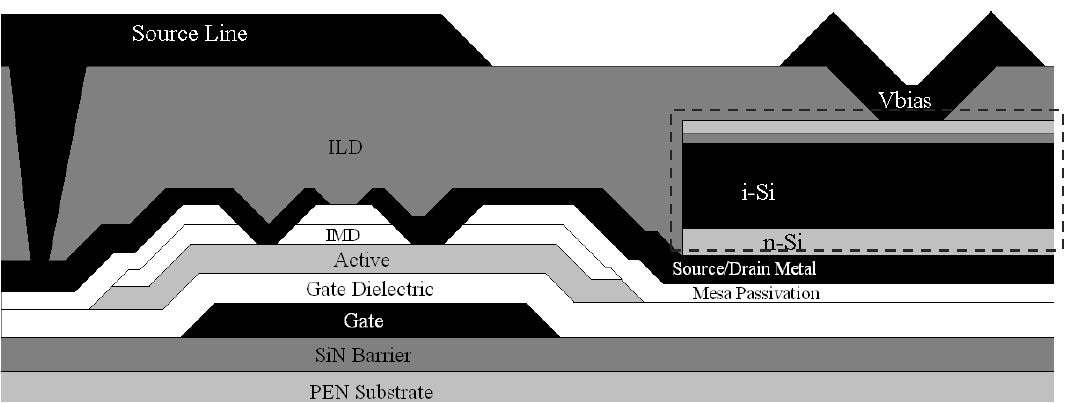
Figure 4. Patterned PIN photodiode connected in series to a TFT.